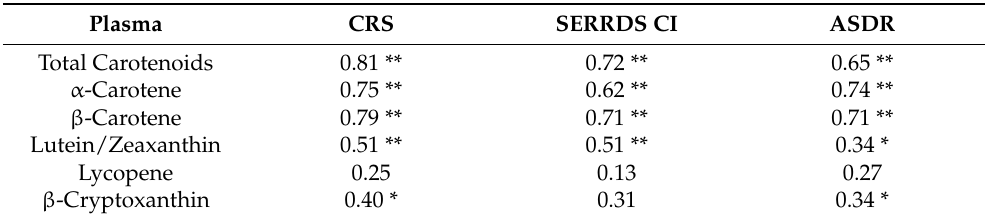
Table 3. Correlations between specific plasma carotenoids from week 4 and week 8 with their re- spective skin levels from week 4 and week 8 and intake data from weeks 1–4 and weeks 5–8 ( n = 42).